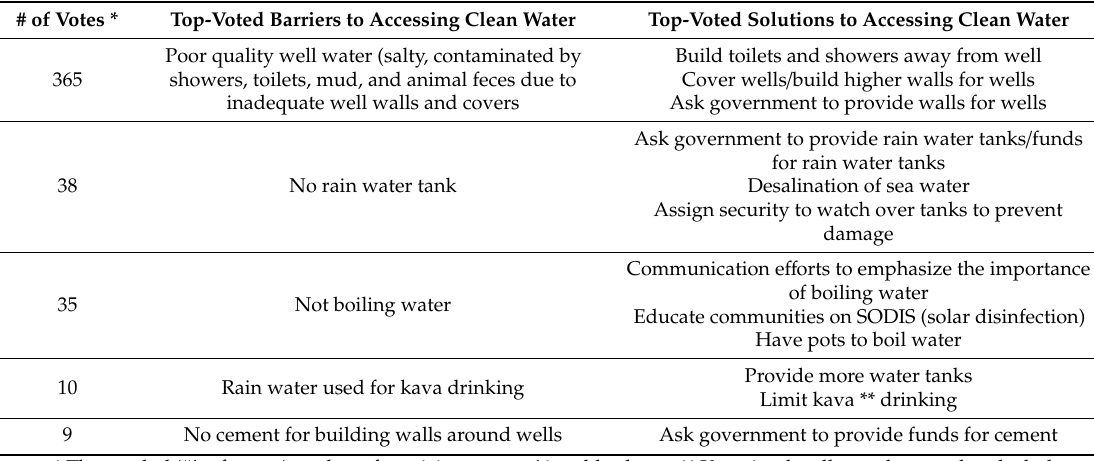
Table 10. Top-voted barriers and solutions to clean water access in Butaritari